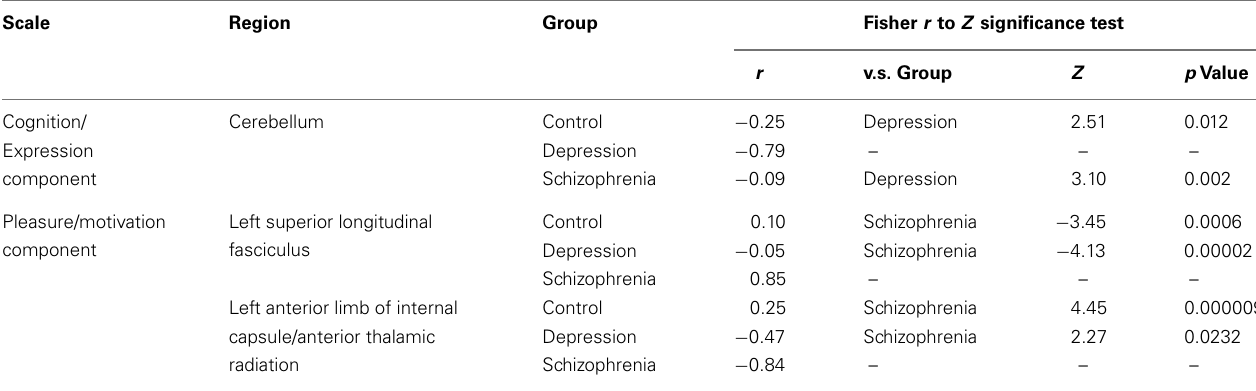
Table 3 | Group differences in the correlation of the brain regions shown in Figure 2 with the negative symptoms of first two principal components .